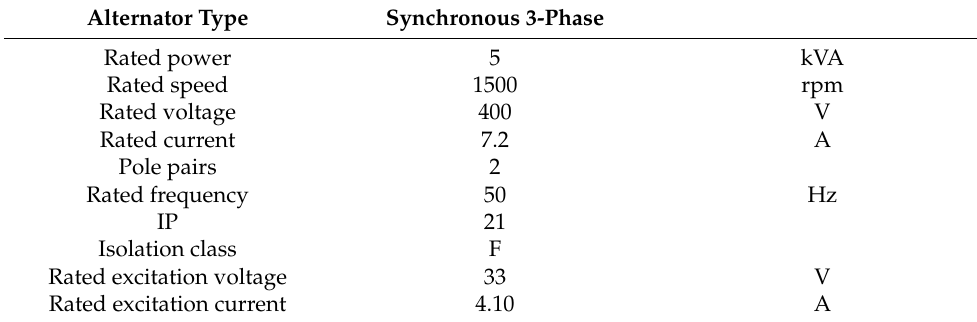
Table 2. Main machine data.